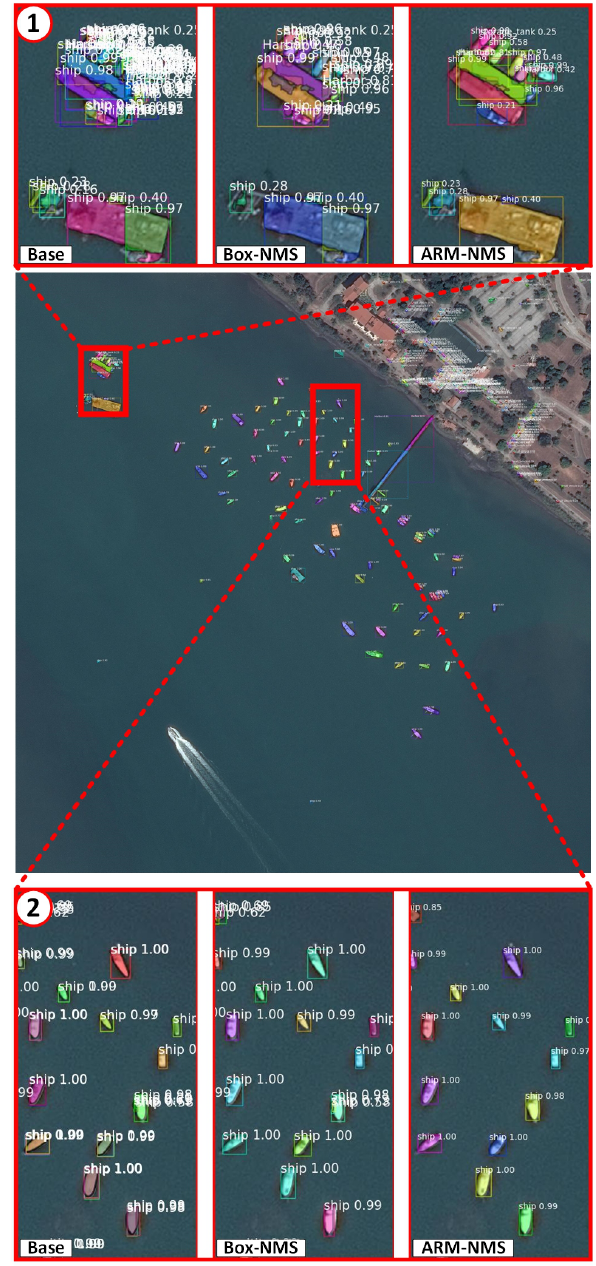
Figure 5. Visualization results on the iSaid: coast. The image sections show the unfiltered base detections, the box-based soft-NMS, and our proposed shape-based ARM-NMS results. (1) The annotation density in this clustered image section can be used to indicate the detection density. Box-NMS can reduce the number of detections, but ARM-NMS outperforms its counterpart significantly. (2) We display a relatively sparse scene with double detections among the